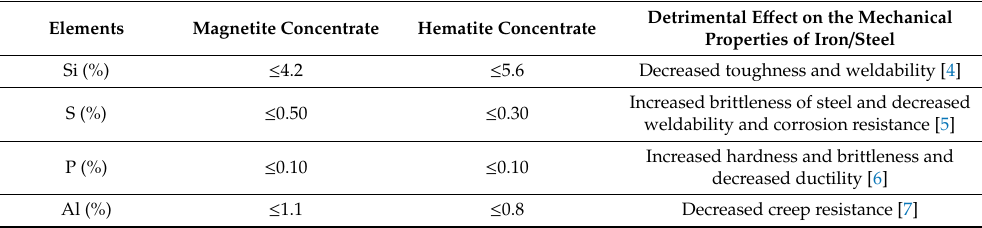
Table 1. The allowed content of the harmful elements in iron ore concentrate [3] and their detrimental e ff ects on